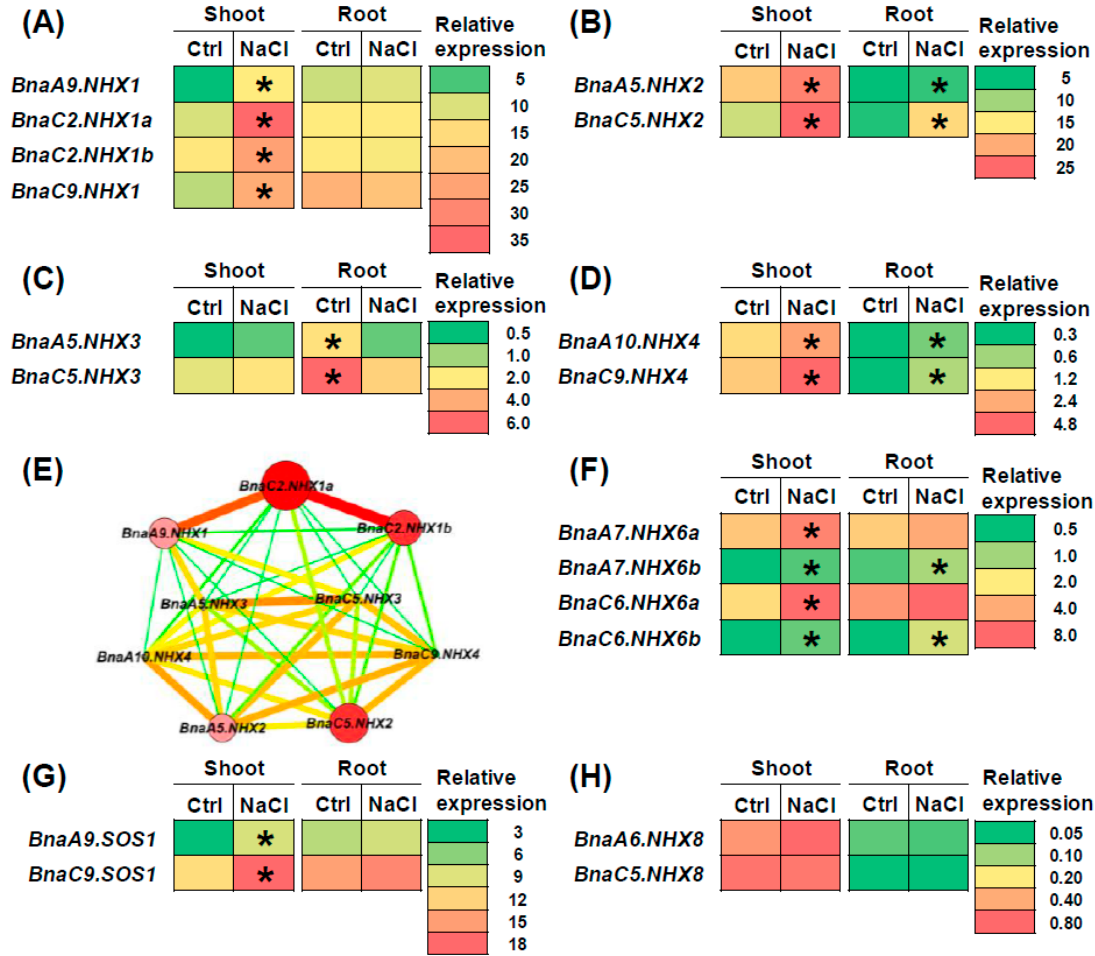
Figure 7. The qRT-PCR assisted transcriptional characterization of the Na + /H + antiporters ( NHXs ) in Brassica napus under salt stress. ( A – D ) Differential expression profiling of: BnaNHX1s ( A ), BnaNHX2s ( B ), BnaNHX3s ( C ), and BnaNHX4s ( D ) between the control (Ctrl) and salt stress. ( E ) The gene co- expression network diagram involving BnaNHX1 s, BnaNHX2s , BnaNHX3s , and BnaNHX4s . ( F – H ) Differential expression profiling of BnaNHX6s ( F ), BnaSOS1s/BnaNHX7s ( G ), and BnaNHX8s ( H ) under salt stress. For the transcriptional analysis, the 7 d-old uniform B. napus seedlings after seed germination were hydroponically cultivated in a NaCl-free solution for 10 d, and then were transferred to 200 mM NaCl for 12 h until sampling. The shoots and roots were individually sampled, and each sample includes three independent biological replicates. The significance level of p < 0.05 is used as the threshold to identify the differential BnaNHX expression under salt stress. The differentially expressed genes with higher expression are indicated with asterisks.